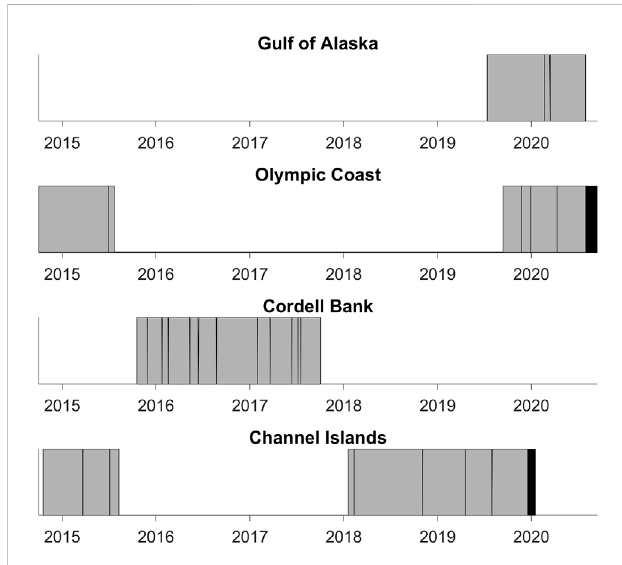
FIGURE 2 Durationofeachdeployment ’ saudiodata.Grayindicatesdataused in this study. Black indicates data collected during the deployment that werenot used in thestudy. White indicates data gaps. See Table 1 for the start and end dates of each deployment.